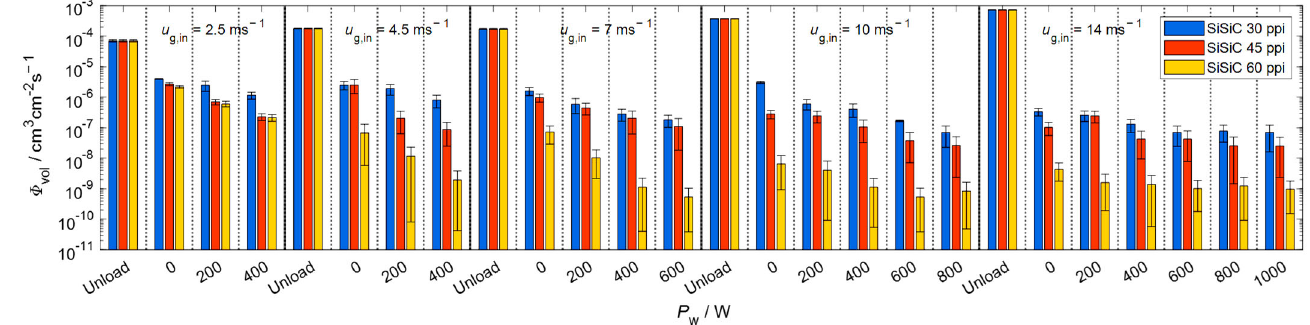
Figure 11. Relative span factor of droplets crossing the outlet position of the microwave applicator loaded with SBSiC ( top ), SSiC ( middle ) and SiSiC ( bottom ) foams at an input magnetron power up to 1 kW.